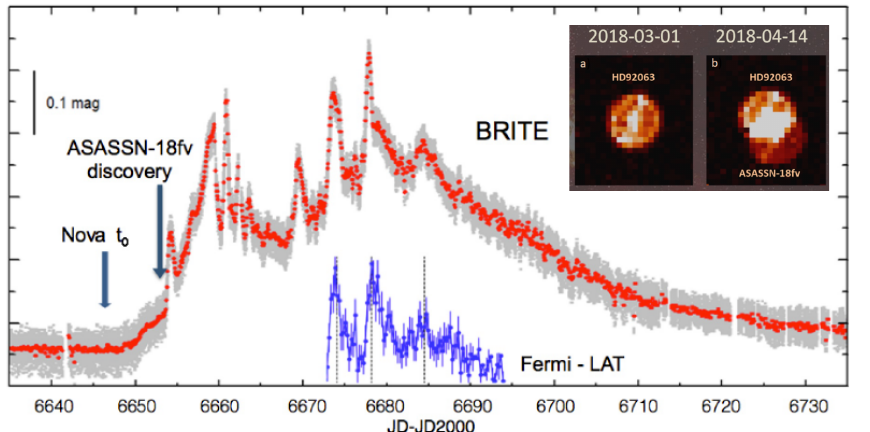
Figure 23. BRITE-Toronto photometry of Nova Carinae 2018 (grey: individual observations with red filter, red: orbit averages). Blue: Fermi-LAT (Atwood et al. [119]) γ -ray observations. Inserts: raster centred on HD92063, taken on 1 March 2018 before nova eruption ( left ), and on 14 April 2018 during nova eruption ( right ). Scale is 27 (cid:48)(cid:48) per pixel, and exposure times are